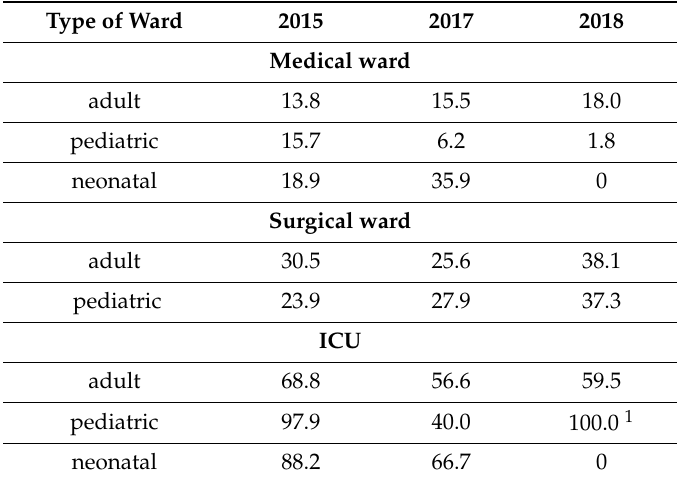
Table 2. Overall antimicrobial prevalence by type of ward (%).